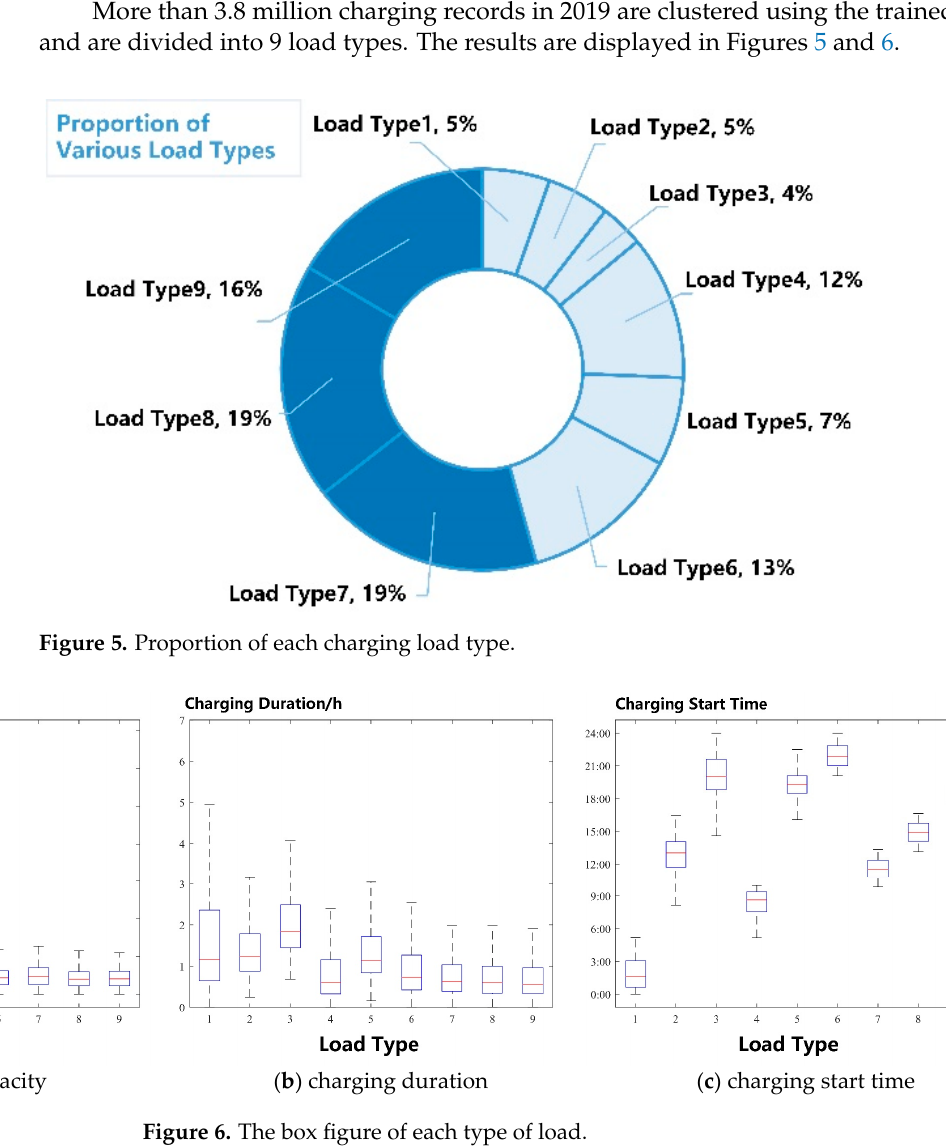
( b ) Training result of 2019 data Figure 4. SOM output layer topology. 4.1. Cluster Analysis More than 3.8 million charging records in 2019 are clustered using the trained SOM and are divided into 9 load types. The results are displayed in Figures 5 and 6. Load types 4, 6–9 account for nearly 80% of all charging records. The difference in the distributions of charging capacity and duration, of which the average values are be-